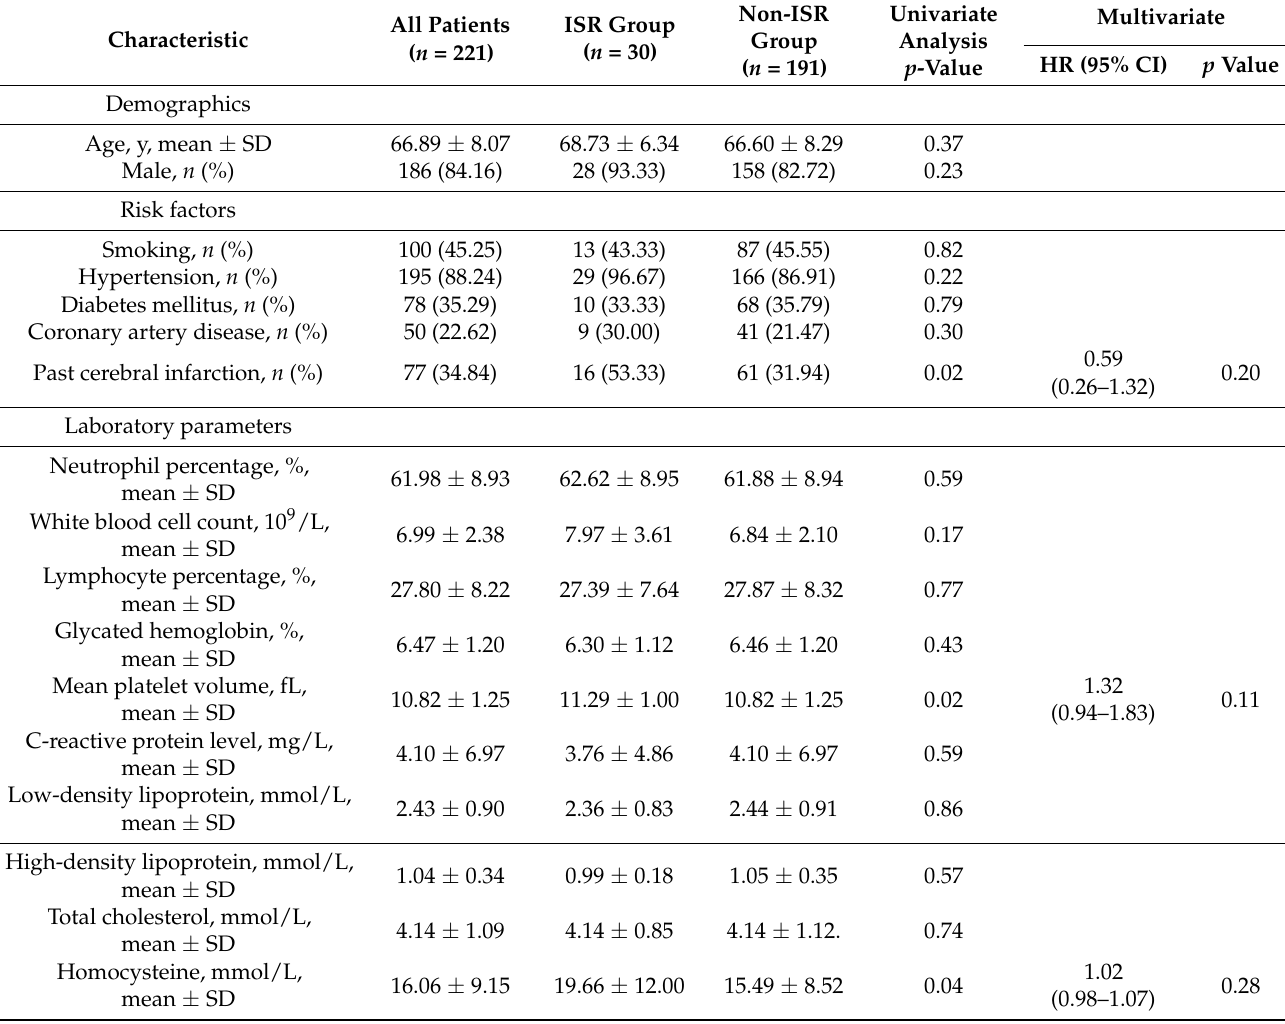
Table 1. Clinical, laboratory, and carotid artery plaque characteristics of the